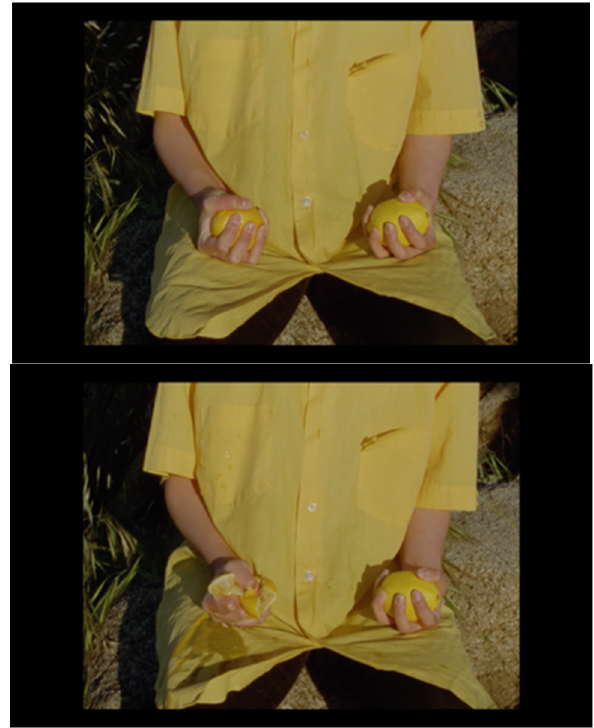
Figure 8. Words, Planets (2018).